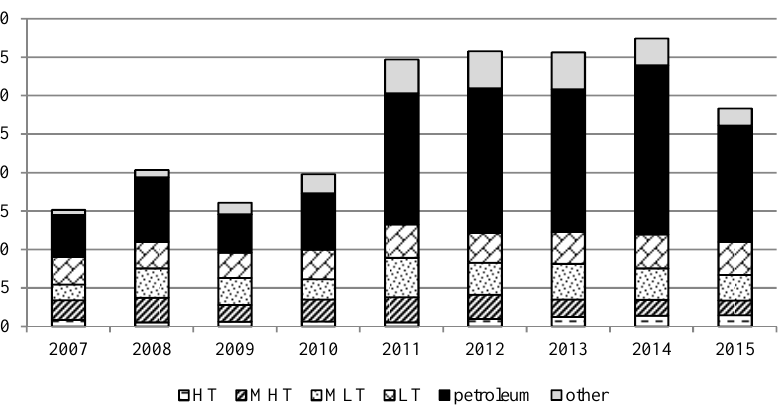
Figure 2. Goods structure of Russian exports to China in 2007–2015 (billion USD)